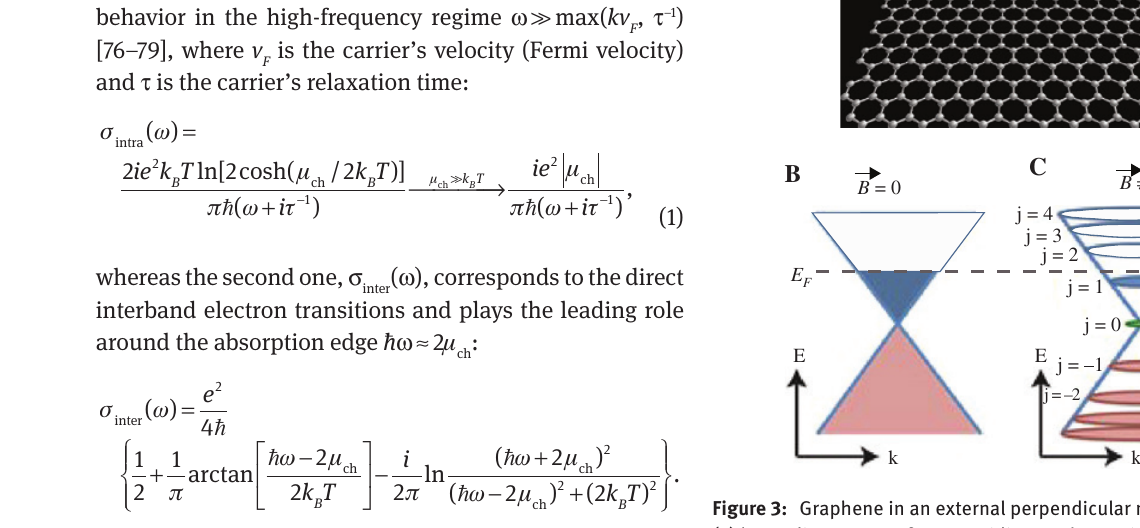
Figure 3: Graphene in an external perpendicular magnetic field (A) has a discrete set of non-equidistant electronic energy levels (Landau levels) in contrast to zero magnetic field (B,